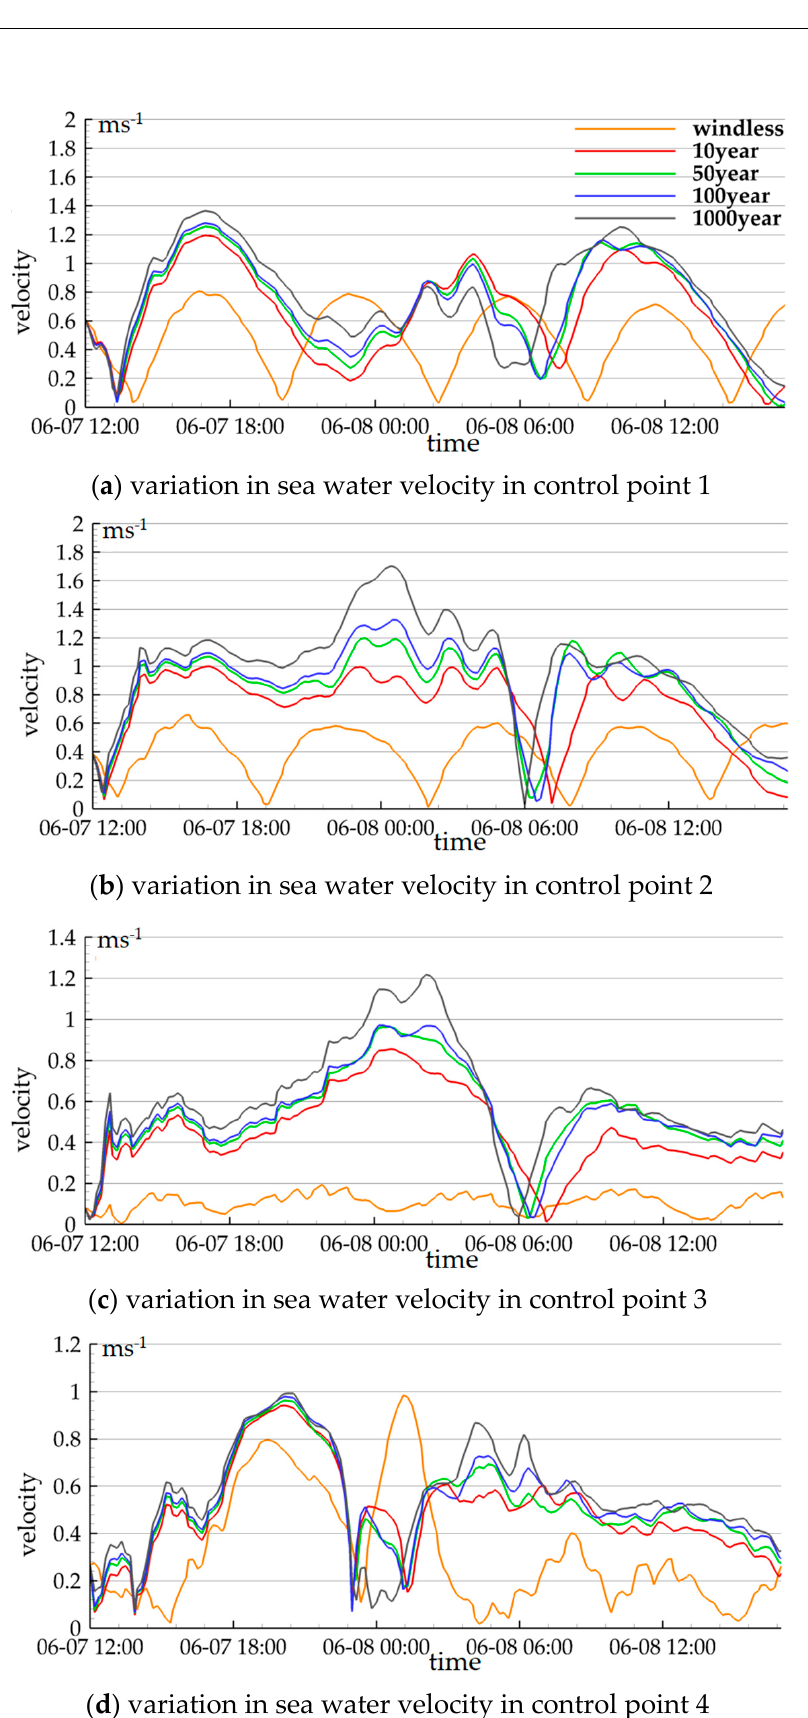
Figure 17. Sea current velocity curves induced by typhoons in different recurrence periods.